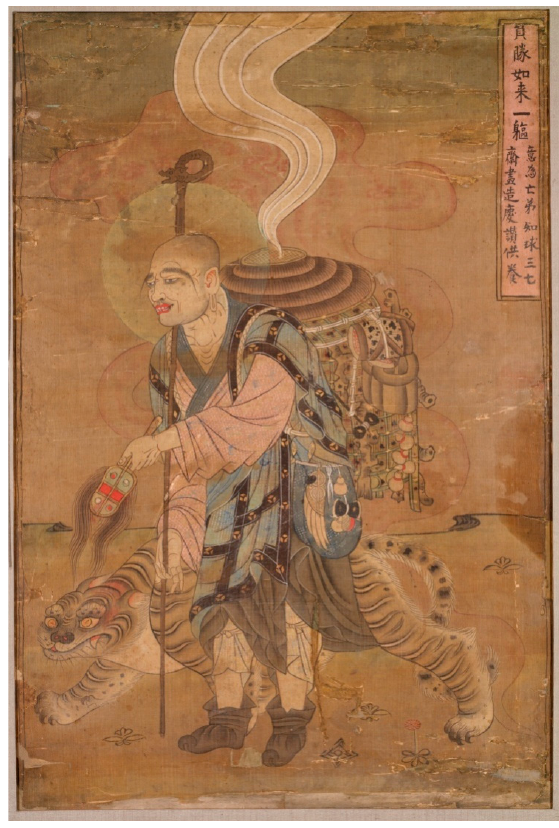
Figure 2. Itinerant Monk . Dunhuang, 9th–10th century. Ink and colors on silk, 79.8 × 54.0 cm. Musée Guimet (EO.1141). Photo © RMN-Grand Palais (MNAAG, Paris)/image musée Guimet.